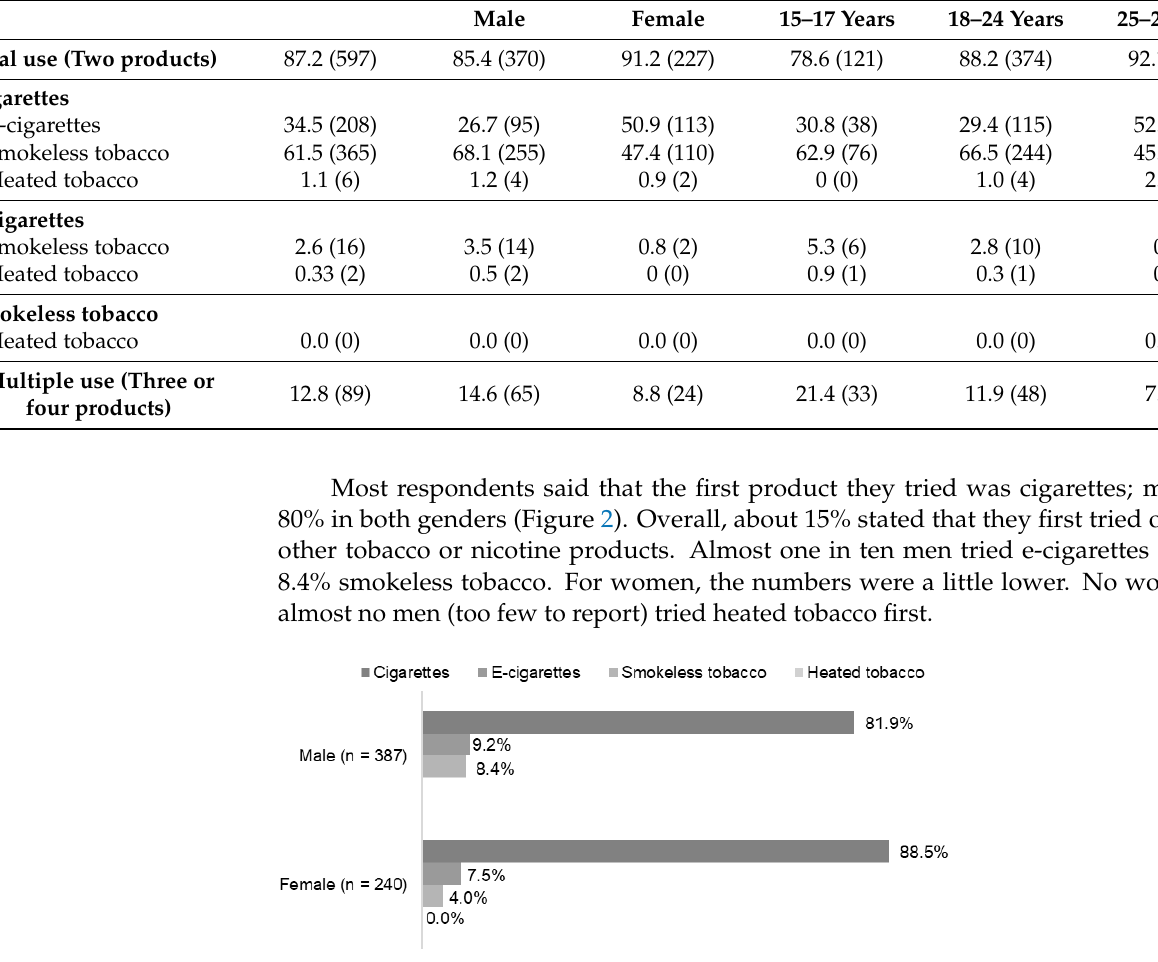
Figure 2. Type of tobacco or nicotine product used first, stratified by gender. Data for the use of heated tobacco among men is not shown due to too few respondents ( n < 5).